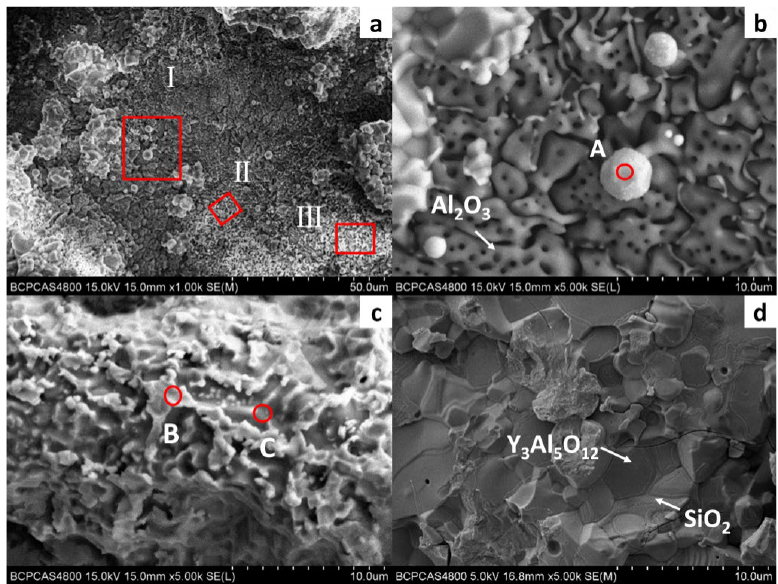
Figure 7. The interfacial reaction between DD6 and Y 2 O 3 mould: ( a ) surface of alloy; ( b ) high magni- fication of zone I ; ( c ) high magnification of zone II ; ( d ) high magnification of zone III .